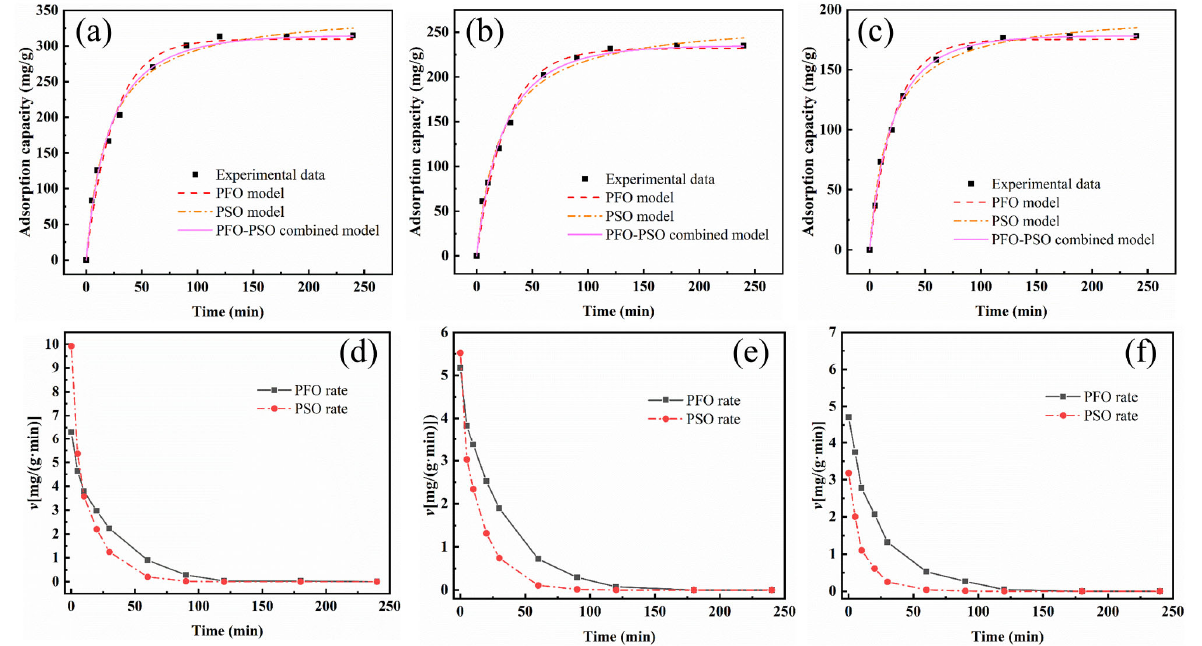
Figure 8. Experimental data of colorant adsorption onto BBC-HAP at initial concentrations of ( a ) 250, ( b ) 200, and ( c ) 150 mg/L predicted by various kinetic models. Contributions of PFO and PSO rates over the whole process of BBC-HAP adsorption of colorant at the initial concentrations of ( d ) 250, ( e ) 200, and ( f ) 150 mg/L (adsorbent dosage, 0.75 mg/mL; pH, 7; temperature, 300 K). Table 4. Kinetic parameters of colorant adsorption by BBC ‐ HAP (adsorbent dosage, 0.75 mg/mL; pH, 7; and temperature, 300 K).